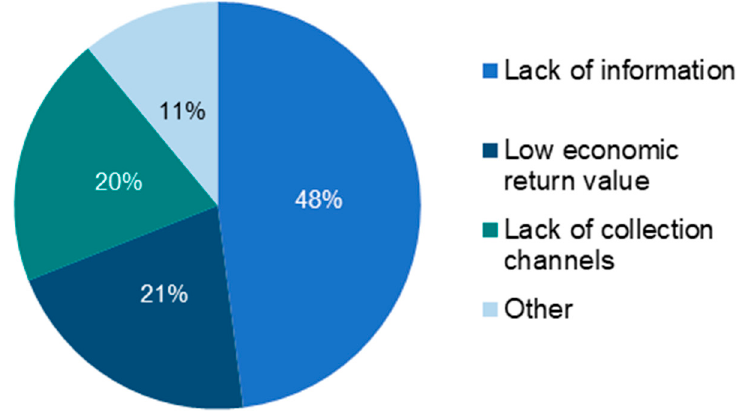
Figure 5. Reasons that make it difficult for consumers to deliver for recycling their electronic equipment at the end of its useful lifetime. Source: Own elaboration based on the results obtained from the national survey (2018).